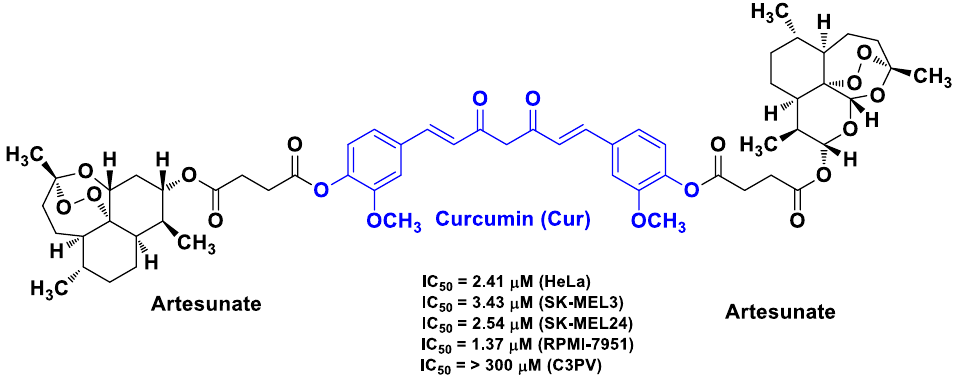
Figure 15. Structure and activity of the most potent dimeric hybrid derivative developed by Botta et al. [64]. Ning et al. developed dual targeting conjugates by joining Res and oxabicyclohep- tene sulfonate (OBHS), a structural motif of estrogen receptor (ER), with the aim of sup- pressing estrogenic and anti-inflammatory activities in breast cancer cells (MCF-7) [52]. The rationale of this design was inspired by evidence that ER/NF- κB interactions are im- plicated in the progression of breast cancer [79,80]. The authors synthesized two series of OBSH – Res hybrids via the Diels – Alder reaction of furan derivatives and various dieno- philes. The most potent compound was found among the type II series and showed re- markable stereospecific binding to ER, excellent NO inhibition in macrophage RAW 264.7 cells, and cytotoxicity in the low micromolar range against MCF-7 cells (Figure 16). In vivo